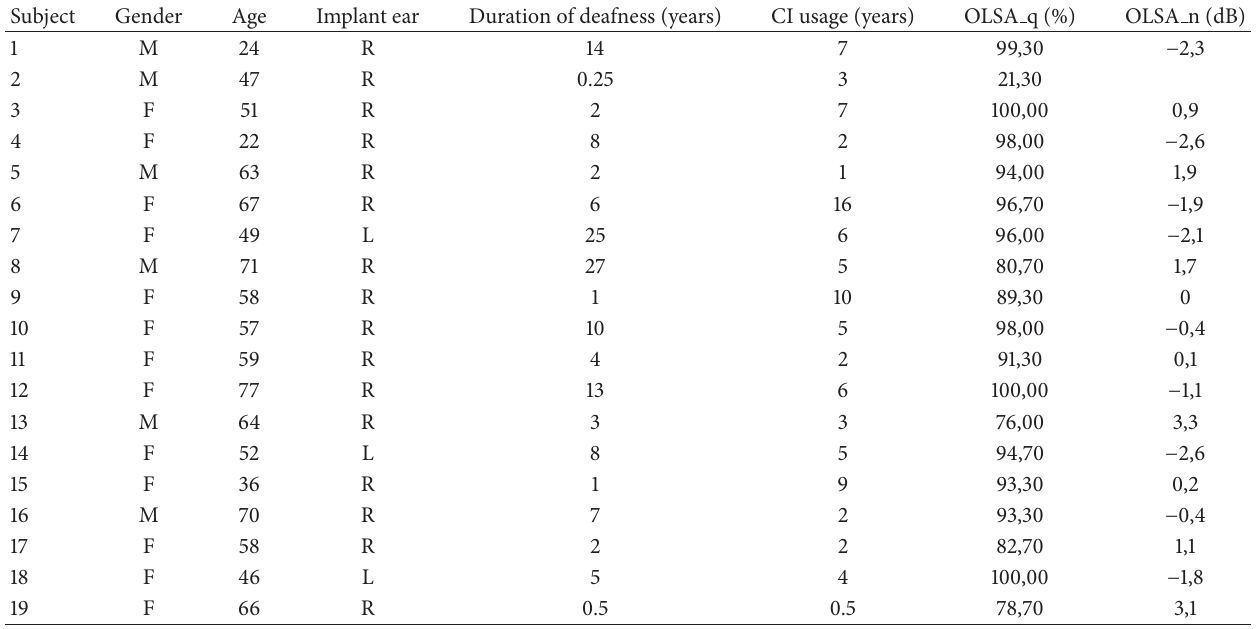
Table 1: Subject demographics of cochlear implant users.